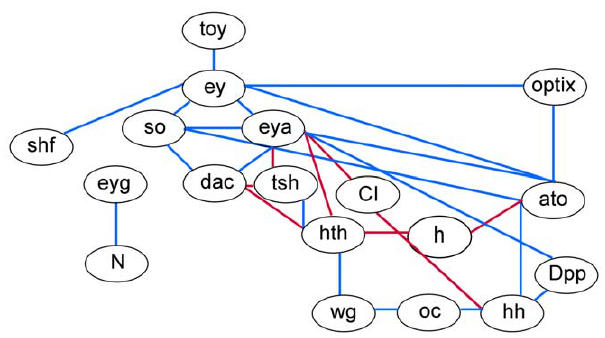
Figure 1. The fly seed network based on experimental results in the literature. Positive correlations between genes are represented by blue edges and negative correlations are represented by red edges. Full names and their abbreviations for Drosophila genes are provided in Table 1.